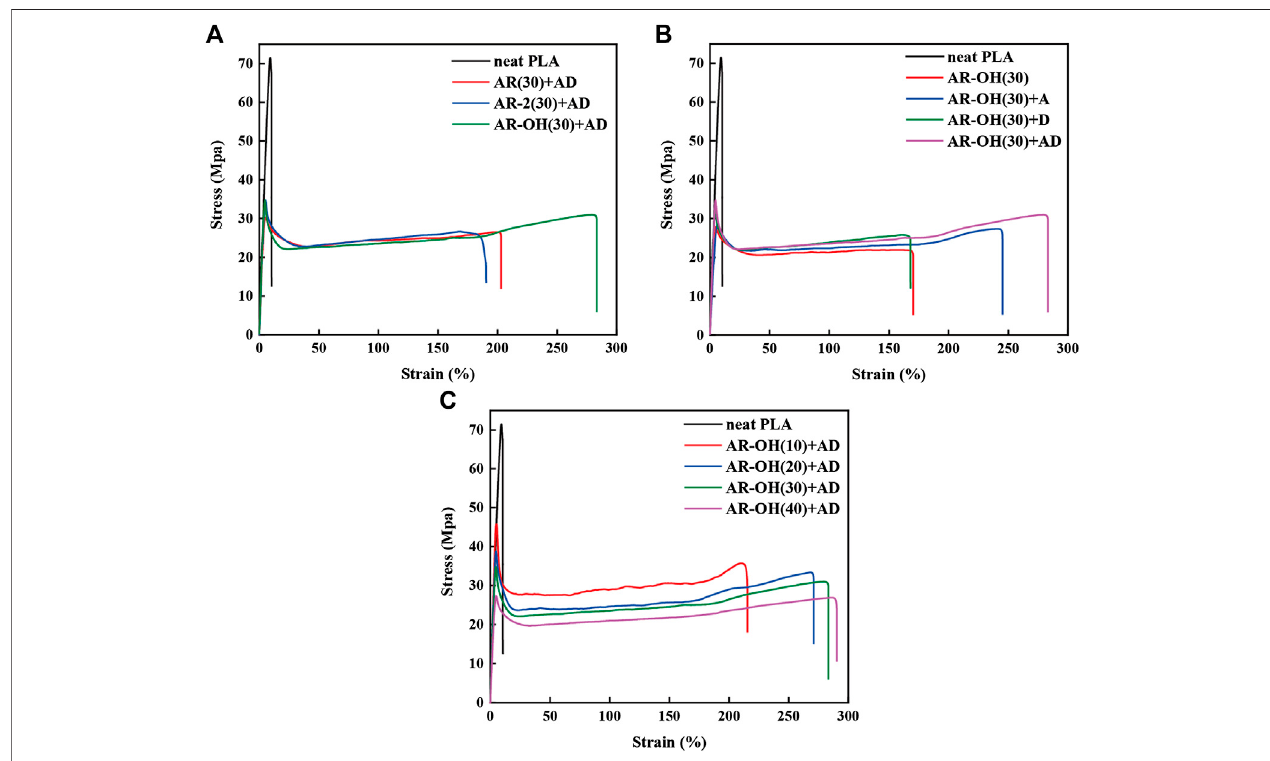
FIGURE5| Tensilestress-straincurvesofthePLA/ i -BIIRsblends: (A) neatPLAandPLA/ i -BIIRsblendswithADRandDCPaddedand30 wt%contentofionomer, (B) neat PLA and PLA/ i -BIIR-OH blends with different addition of ADR and DCP, (C) neat PLA and PLA/ i -BIIR-OH blends with different ionomer content.